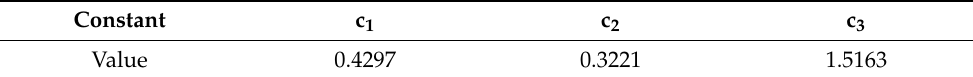
Figure 11. CaCl 2 maximum water uptake ( θ max ) at different temperatures (ambient temperature = 25 ± 2 °C). Table 2. Constants related to the CaCl 2 maximum water–mass ratio uptake.